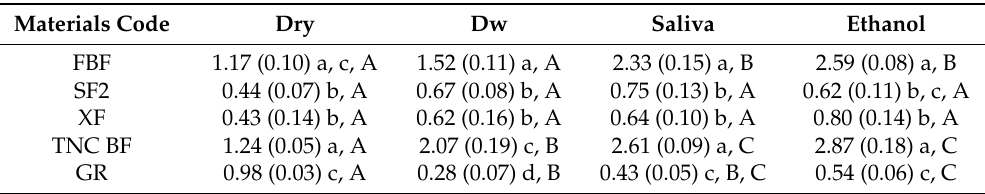
Table 3. Max creep strain %.